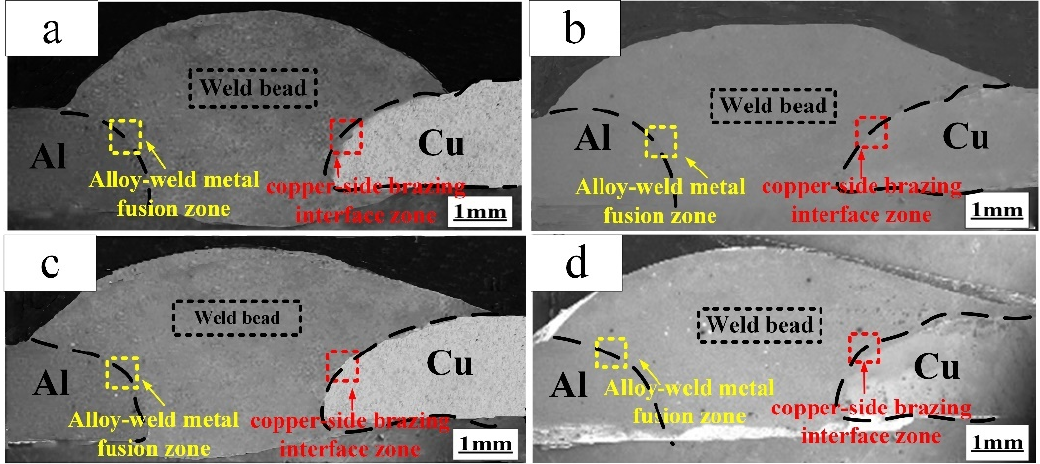
Figure 5. Cross section of the butt joints ( I main = 60 A). ( a ) ER1100 filler wires; ( b ) ER5356 filler wires; ( c ) ER4043 filler wires; ( d ) ER4047 filler wires.